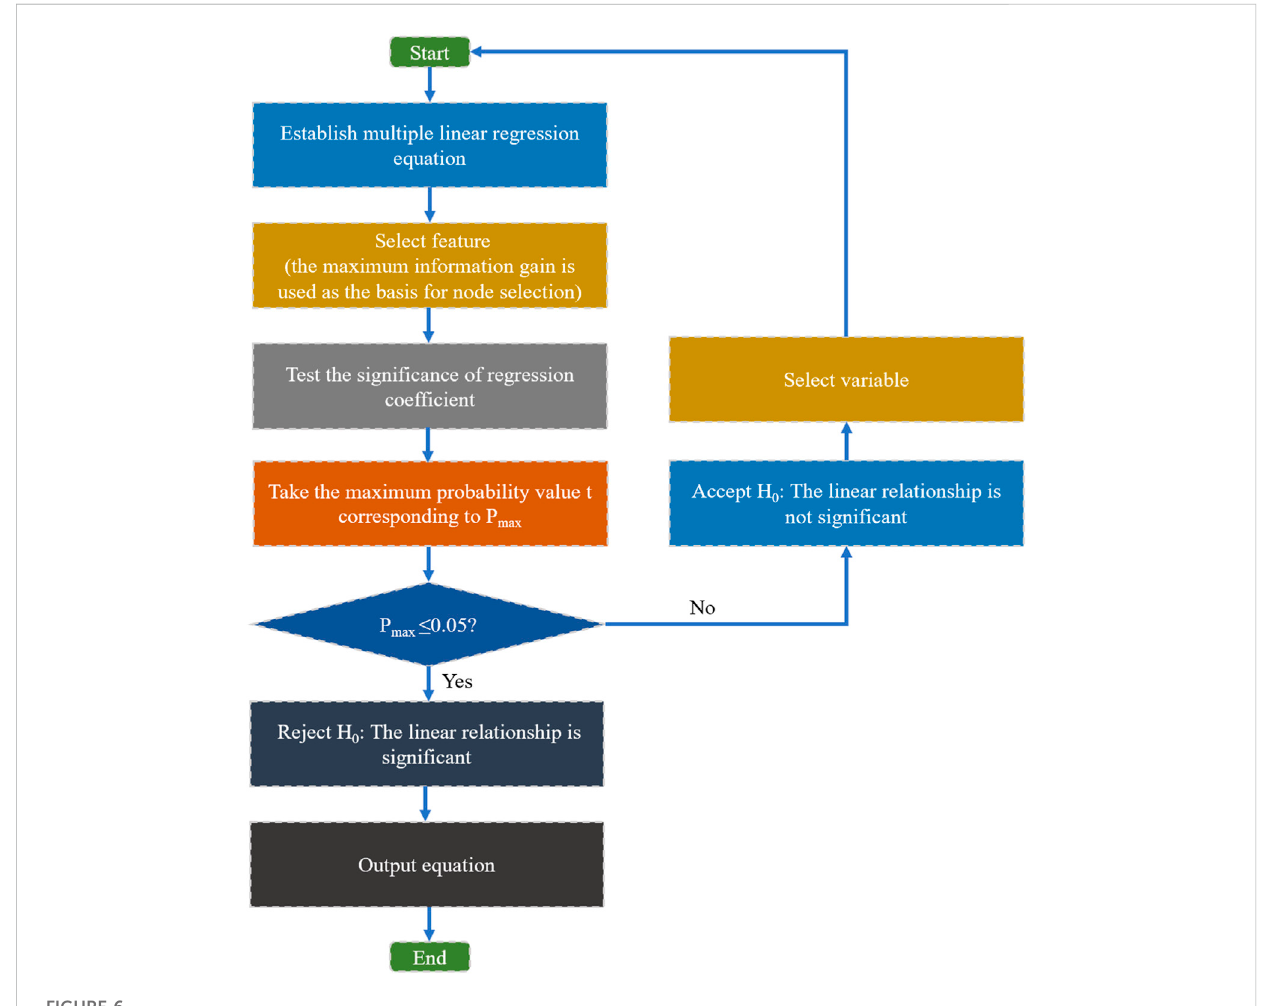
FIGURE 6 The fl ow chart of MLR.